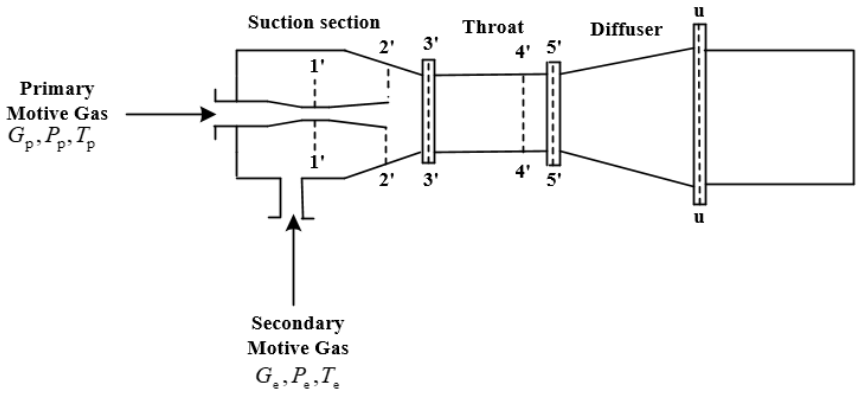
Figure 4. Structure diagram of the ejector.